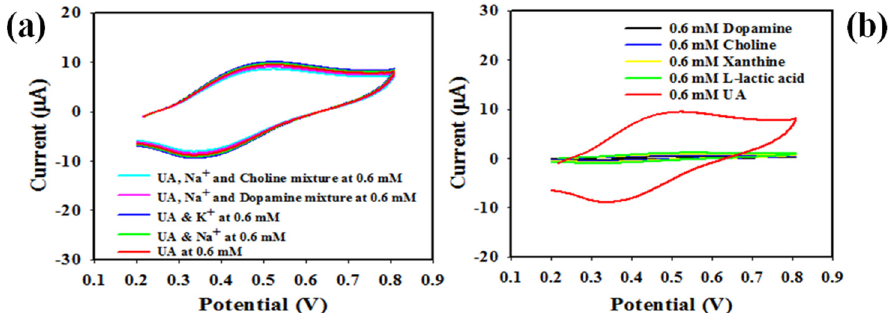
Figure 12. ( a ) Interference effect of UA sensor tested at 0.6 mM concentration of each component in a buffer medium of pH 7.0. ( b ) Selectivity study of UA sensor probe in identical condition in presence of various chemicals.